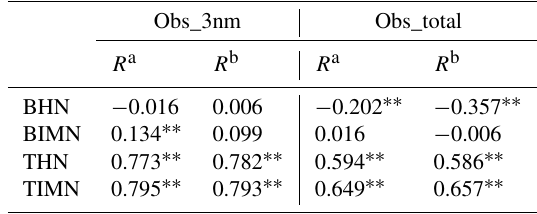
Table 1. Correlation coefficient of observation total and sub-3nm particle number concentrations with the BHN, BIMN, THN, and TIMN scheme,